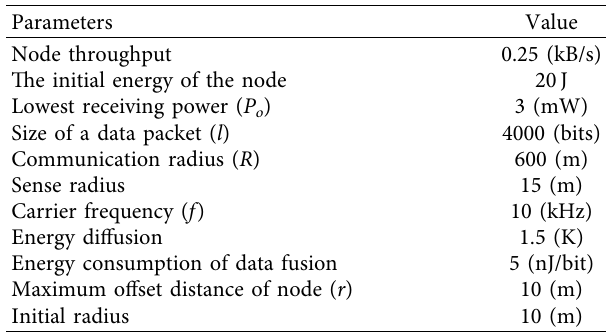
Table 2: Simulation